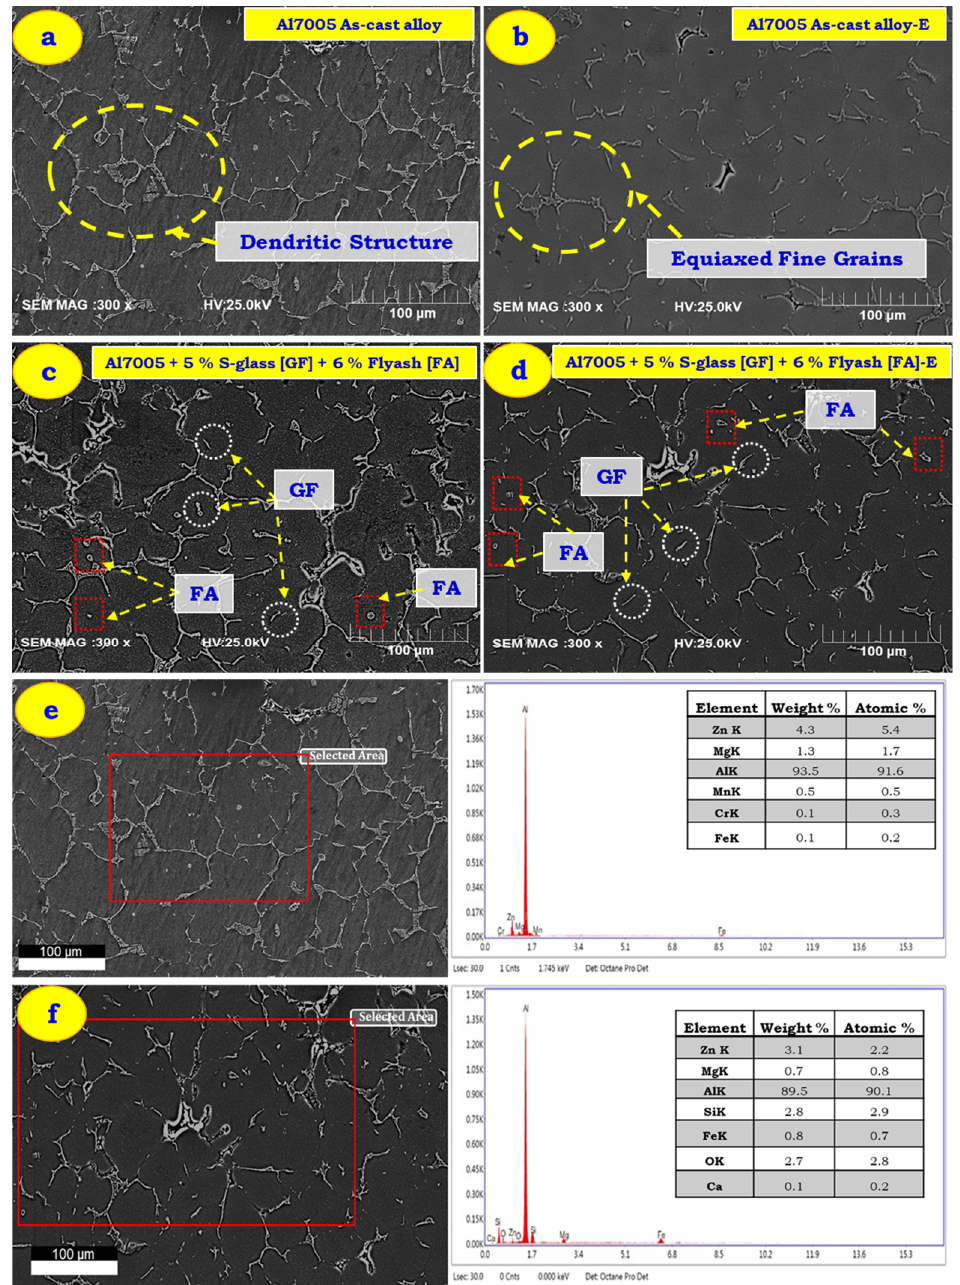
Figure 3. SEM of as-cast and extruded parts at ER: 5.32:1. ( a , b ) Al 7005 before and after extruded conditions, ( b ) Al 7005 + 5%GF, ( c , d ) Al 7005 + 6% FA + 5% GF before and after extruded conditions, ( e ) EDX of as-cast Al 7005, ( f ) EDX of Al 7005 + 6% FA + 5% GF after extrusion.